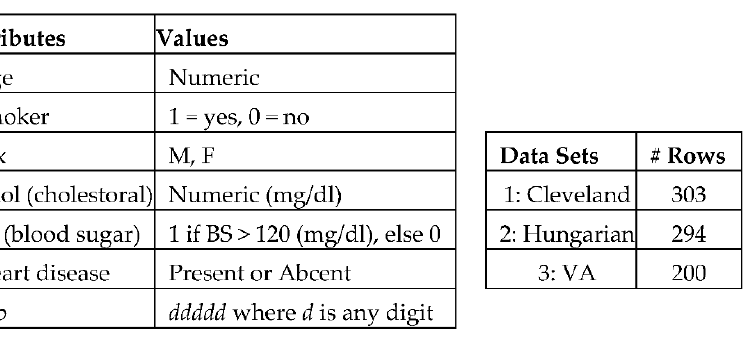
Figure 6. Summary of the Three Data Sets.